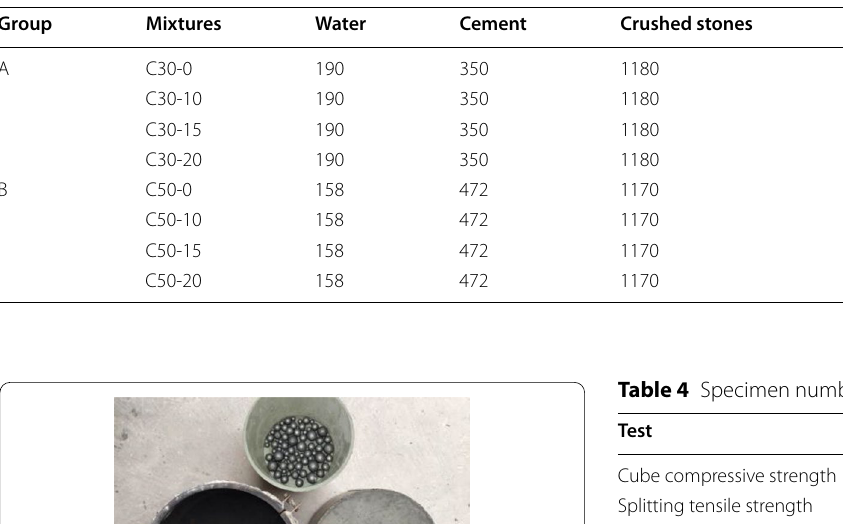
Table 3 Concrete mixture proportions (kg/m 3 )